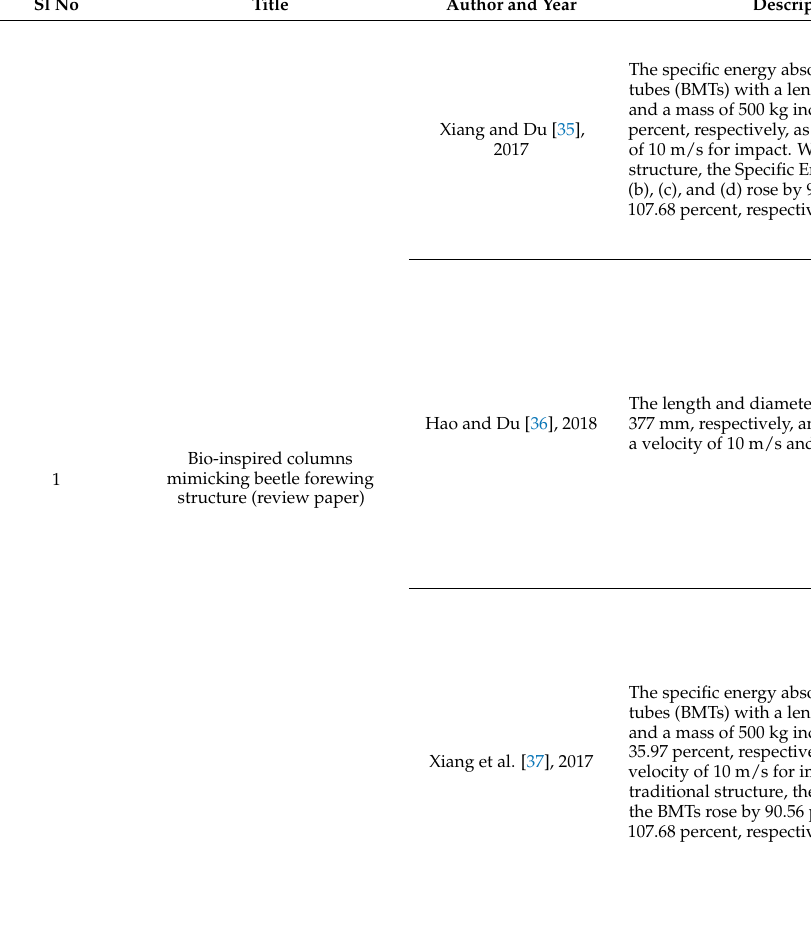
Table 1. Bio-inspired design models built by predecessor